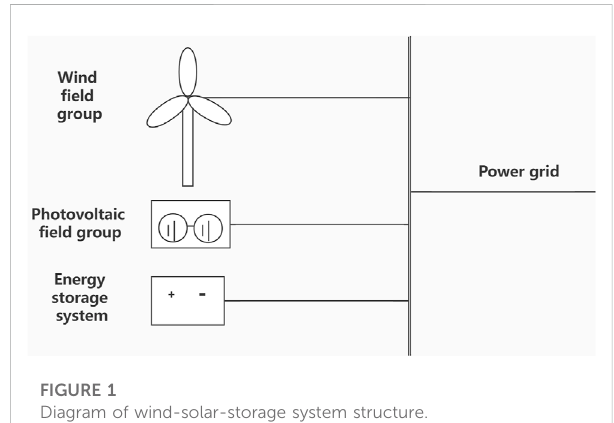
FIGURE 1 Diagram of wind-solar-storage system